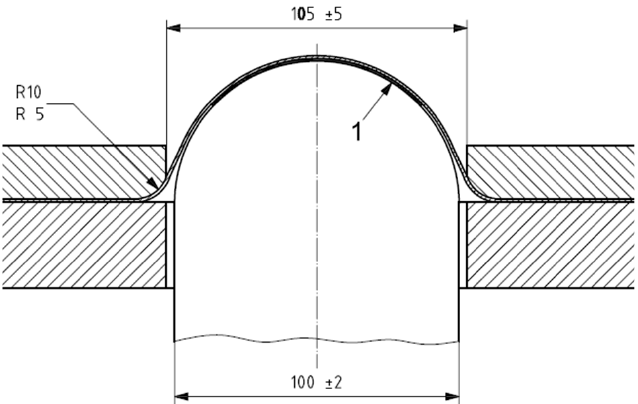
Figure 3. Illustration of the cross-section of the used tool (dimensions are in mm). The image is from ISO 12004.